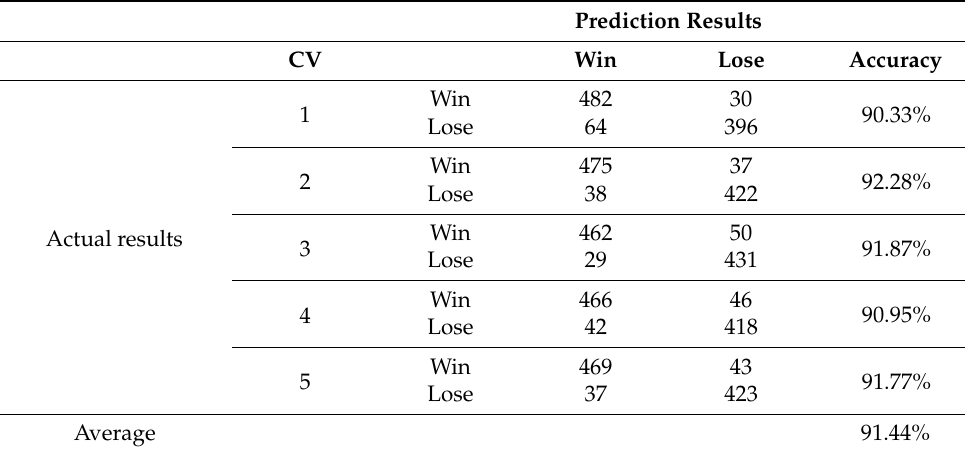
Table 6. Confusion matrix of 1DCNN (dataset